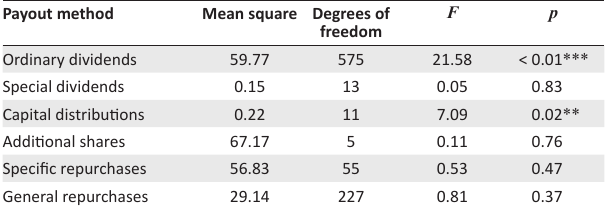
TABLE 2: Analysis of variance of payout methods (High ownership